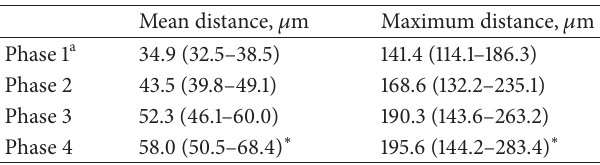
Table 3: Monte Carlo simulations of mean and maximum